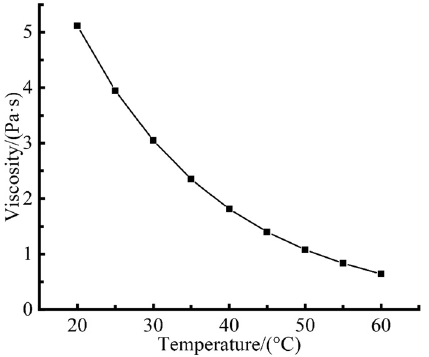
Figure 2. Viscosity-temperature variation curve of MR